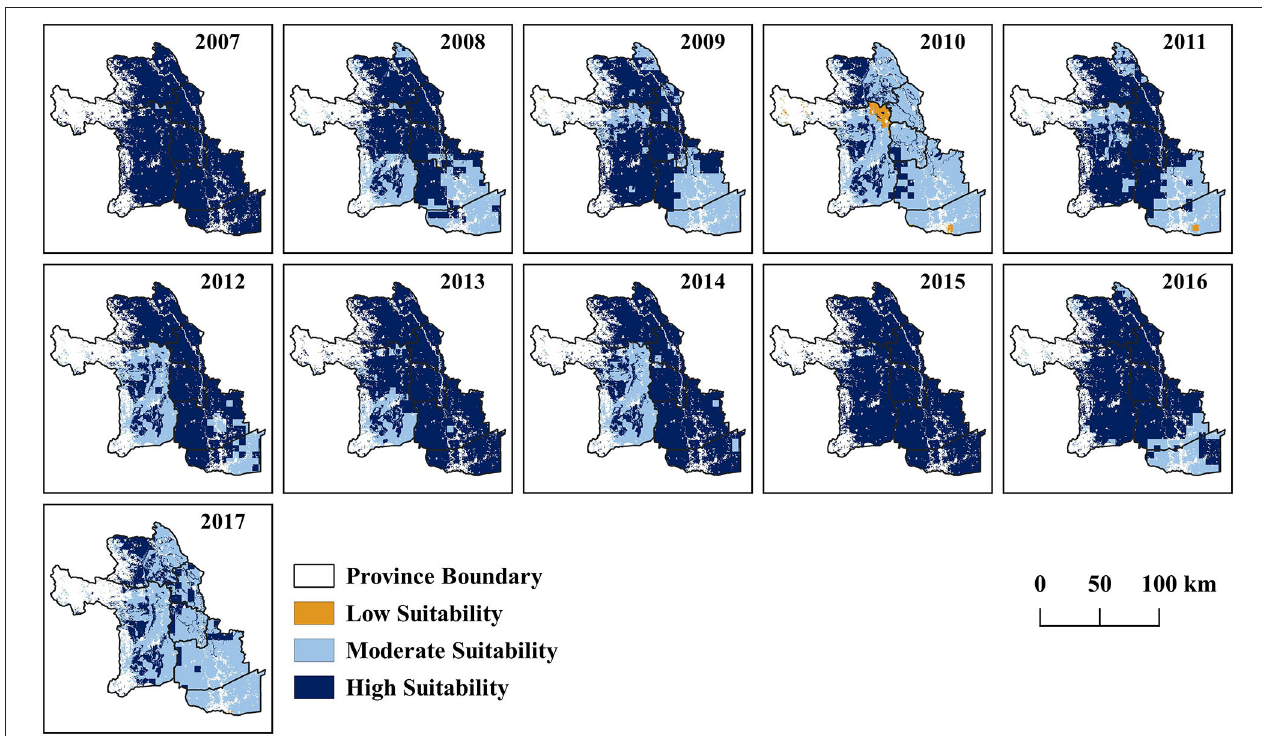
FIGURE 9 | Inter-annual variation of AWD suitability in the major rice season. Colors for each suitability score are same as Figures 7 , 8 .